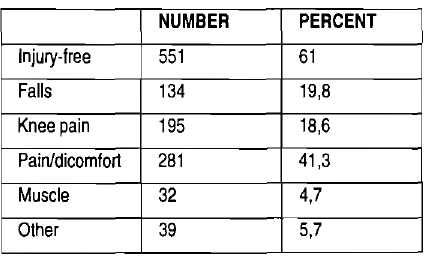
TABLE 1: The occurrence of injuries in all cyclists: